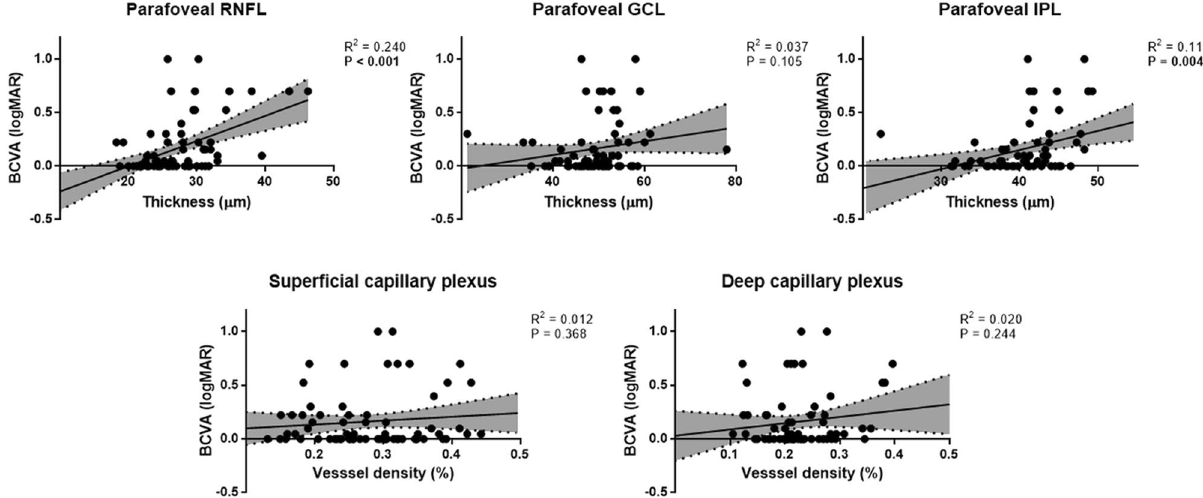
Figure 5. Scatterplots and linear regression analyses between final parameters of optical coherence tomography and optical coherence tomography angiography and final best-corrected visual acuity. BCVA best-corrected visual acuity, RNFL retinal nerve fiber layer, GCL ganglion cell layer, IPL inner plexiform